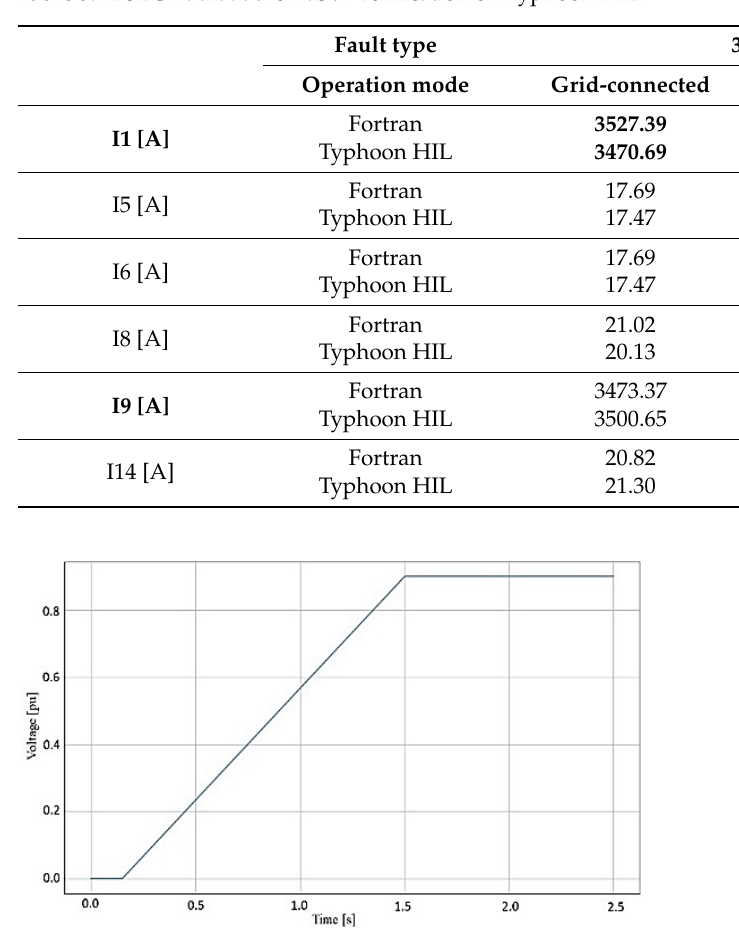
Table 5. A 3LG Fault at the Bus 9: verification on Typhoon HIL.